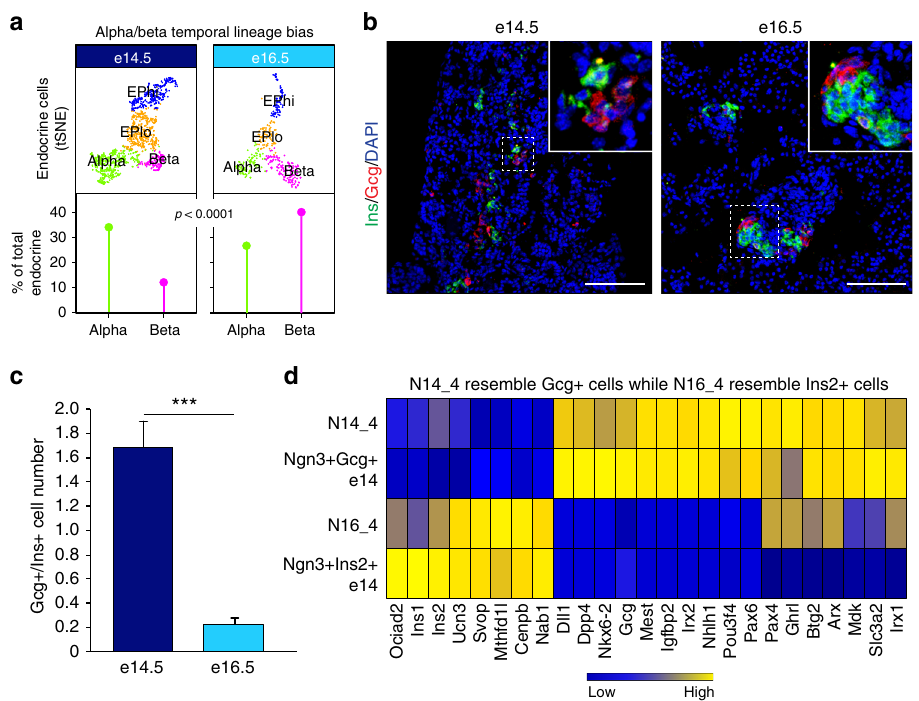
Fig. 6 Temporal lineage bias of Ngn3 + cells leads to more beta cells forming at e16.5. a Abundance of alpha and beta cells at e14.5 compared to e16.5. At e14.5, a higher percentage of alpha cells compared to beta cells were found compared to the overall number of endocrine cells in the pancreas. At e16.5, a higher percentage of beta cells compared to alpha cells were found. The top panel shows tSNE representation of endocrine populations with quanti fi cation below. p < 0.0001, Fisher ’ s exact test. b Representative immunostaining of e14.5 and e16.5 pancreas for alpha (marked in red by Gcg) and beta (marked in green by Ins) cells. Nuclei are marked by DAPI in blue. Scale bar = 100 μ m. c Quanti fi cation of Gcg + cell number over Ins + cell number from e14.5 and e16.5 pancreata. N = 4 e14.5 and N = 6 e16.5 biological replicates. p < 0.005 by two-sided Student ’ s t -test. d Priming of e14.5 Ngn3 + cells for the alpha cell fate and e16.5 Ngn3 + cells for the beta cell fate. Average cluster log2 z -score normalized heatmap showing expression of select alpha and beta cell genes ( x -axis) in late non-hormonal Ngn3 + cells from e14.5 and e16.5 (N14_4 and N16_4) compared to the earliest born hormonal cells still expressing Ngn3 ( y -axis). Expression ranges from blue (low) to high